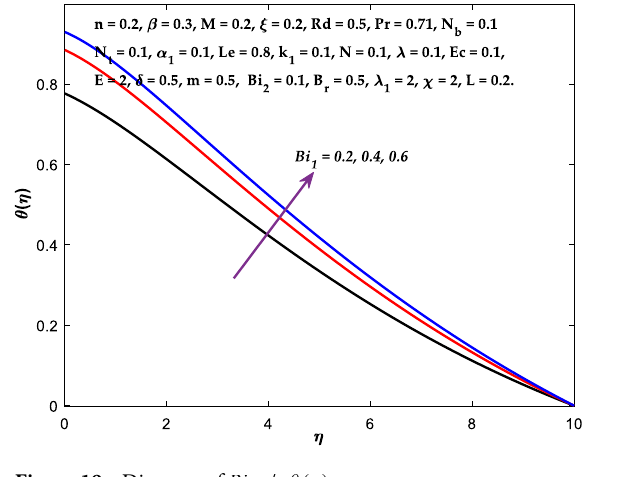
Figure 19. Diagram of Bi 1 v/s θ(η) .